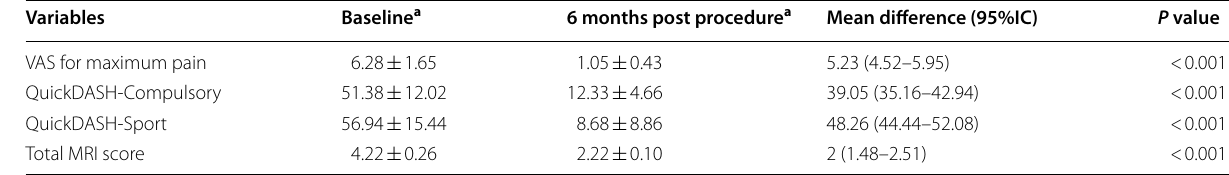
a Values are expressed